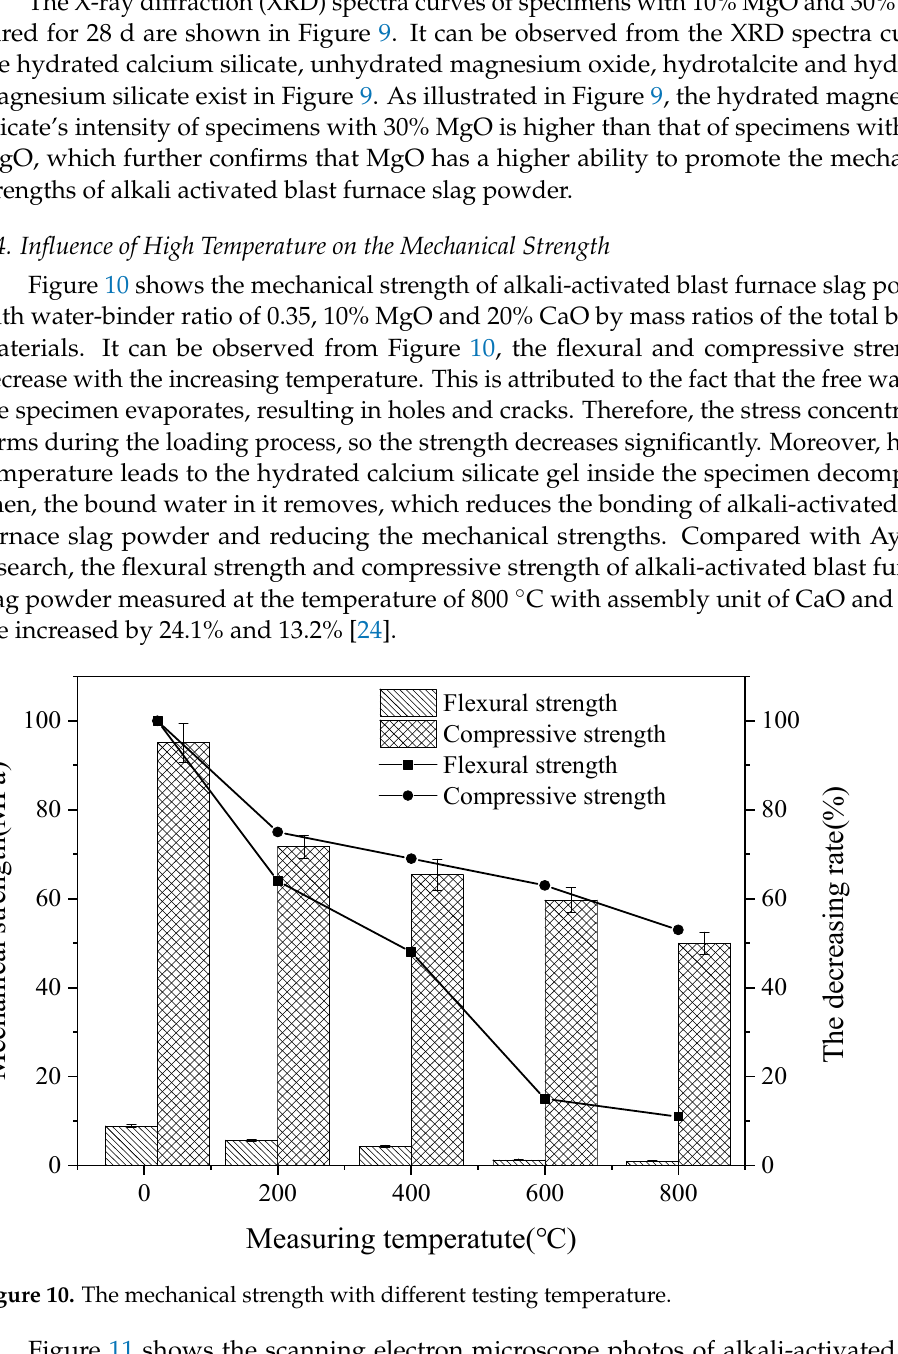
( d ) Figure 11. The SEM morphology of alkali-activated blast furnace slag powder measured at high temperature environment. ( a ) 200 °C. ( b ) 400 °C. ( c ) 600 °C. ( d ) 800 °C.